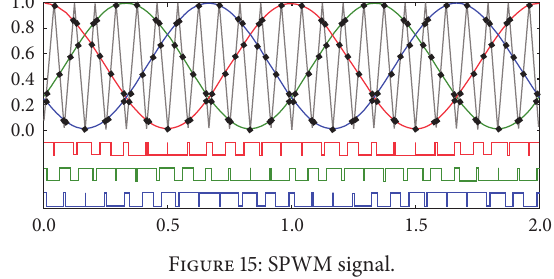
faults. Six DIP switches are connected to input of three- phase inverter gate signals to add faults externally. Designed fault detection and diagnosis monitoring system are shown in Figure